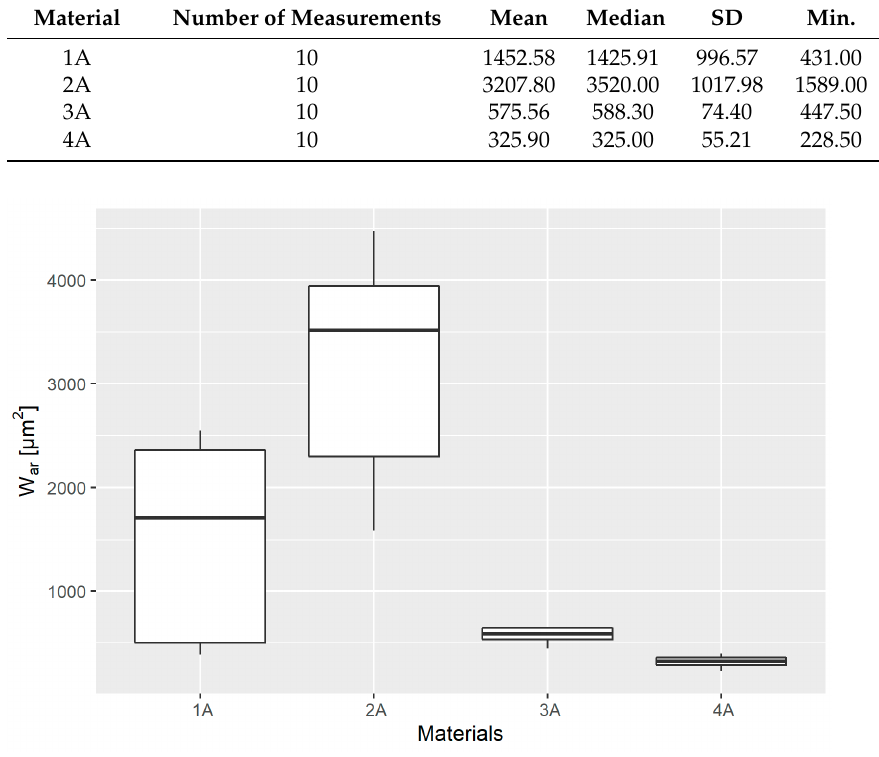
Figure 12. Box plot of tribological wear in individual material groups.